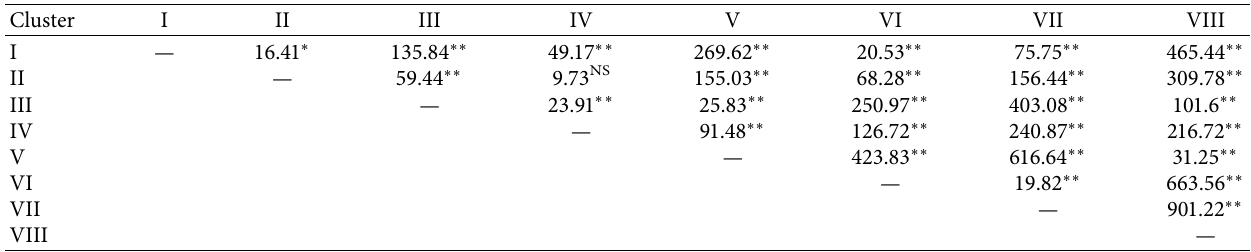
Table 9: Mean value of 10 traits for the eight clusters of 100 common bean genotypes. Traits